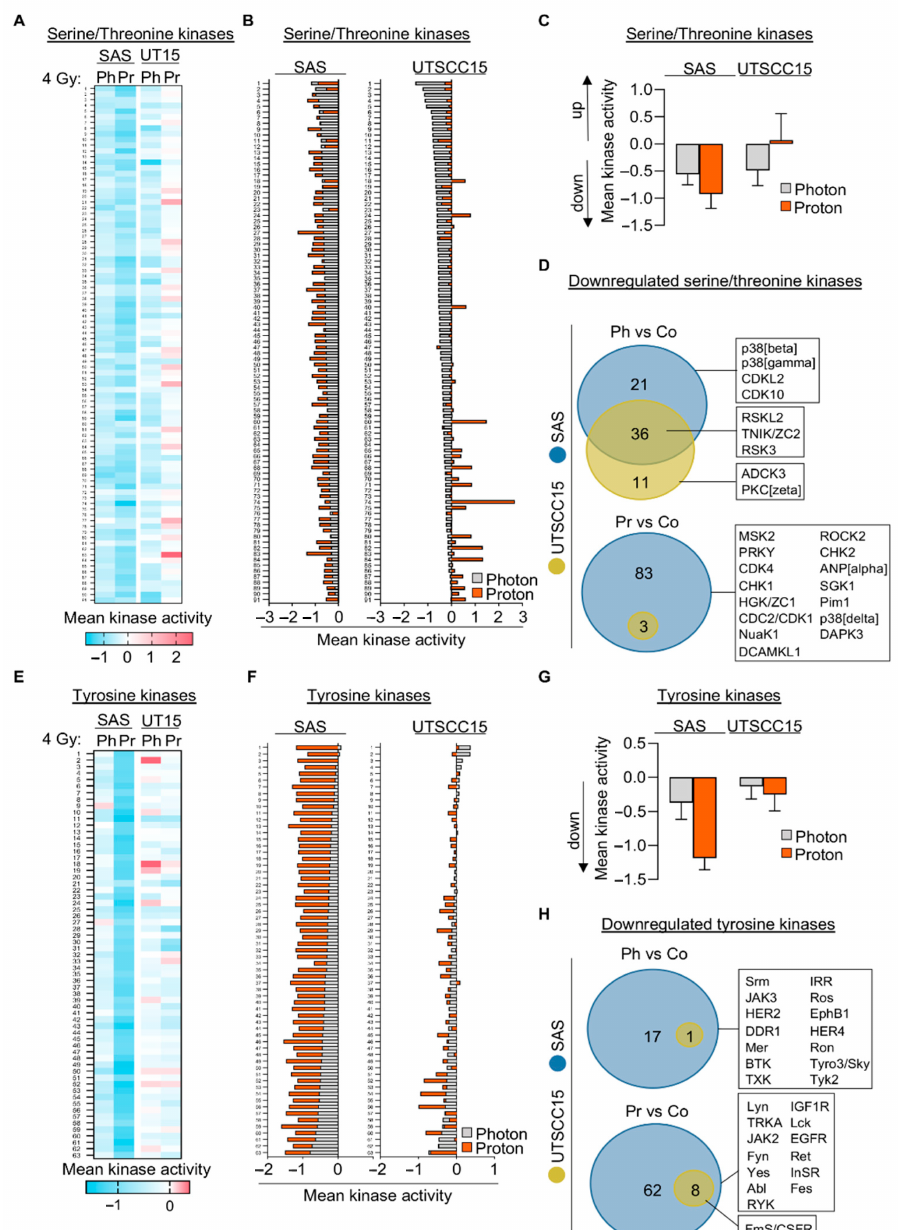
Figure 2. Photon- and proton irradiation induce differential kinome signatures. ( A ) Heatmap and ( B ) superimposed waterfall plot of 91 serine/threonine kinase activities (STK) 2 h after 4-Gy photon or proton irradiation in 3D SAS and UTSCC15 cell cultures normalized to unirradiated controls. ( C ) Mean activity of all investigated STK 2 h after 4-Gy photon or proton irradiation in 3D SAS and UTSCC15 cell cultures normalized to controls. ( D ) Venn diagrams of uniquely and jointly in photon- or proton-irradiated SAS and UTSCC15 cell cultures downregulated STK (mean kinase activity ≤ − 0.5). Boxes display significantly downregulated STK. ( E ) Heatmap and ( F ) superimposed waterfall blot of 63 phosphotyrosine kinase (PTK) activities at 2 h after 4-Gy photon or proton irradiation in 3D SAS and UTSCC15 cell cultures lines normalized to controls. ( G ) Mean activity of all investigated PTK at 2 h after 4-Gy photon or proton irradiation in 3D SAS and UTSCC15 cell cultures normalized to controls. ( H ) Venn diagrams of uniquely and jointly in photon- or proton-irradiated SAS and UTSCC15 cell cultures downregulated PTK (mean kinase activity ≤ − 0.5). Boxes display significantly downregulated PTK. Ph, photon irradiation; Pr, proton irradiation; vs,